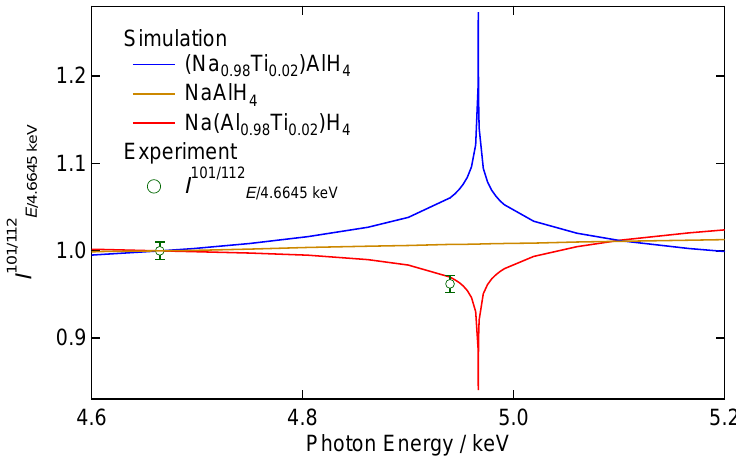
Figure 3. Relative intensity obtained from anomalous X-ray scattering measurement of NaAlH 4 – 0.02TiCl 3 before the desorption. Simulation curves represent the Ti-substituted Al, Ti-substituted Na, and nonsubstituted cases.